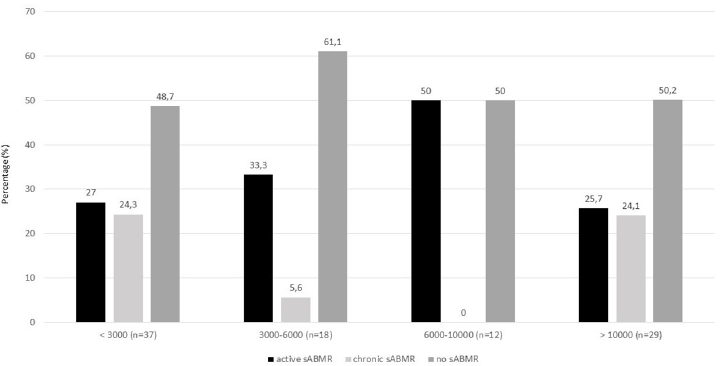
Fig 3. Proportion of the 3 histological diagnoses according to different range of intensity (BCM) of sDSA according to Immucor Lifecodes SAB assay. The numbers on the top of each bar refer to the percentage of each histological pattern. sDSA: sum of the DSA; SAB: single antigen beads.